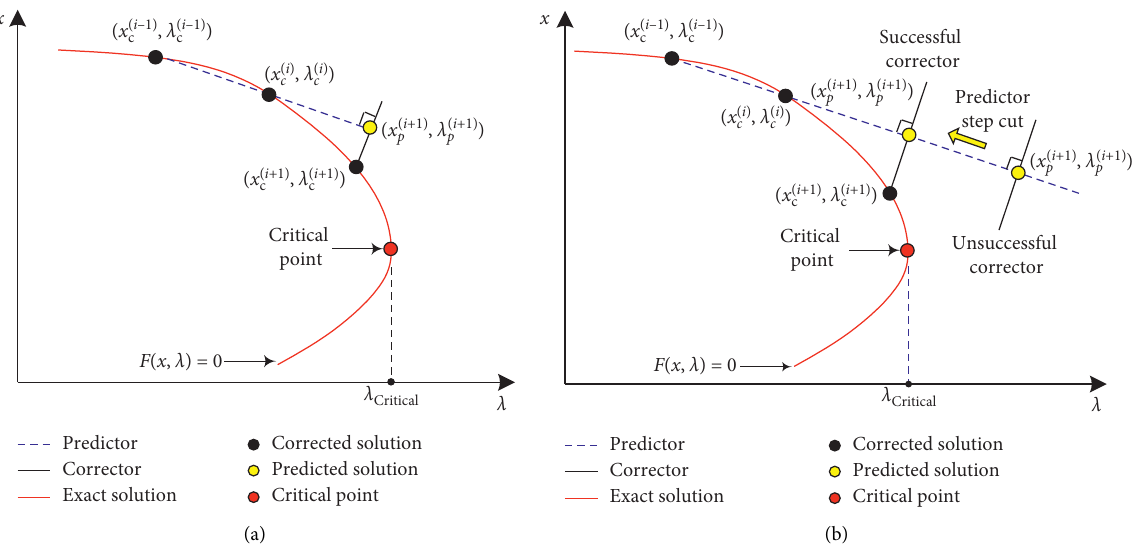
Figure 2: The secant predictor-corrector procedure of the proposed method: (a) smooth function and (b) flat